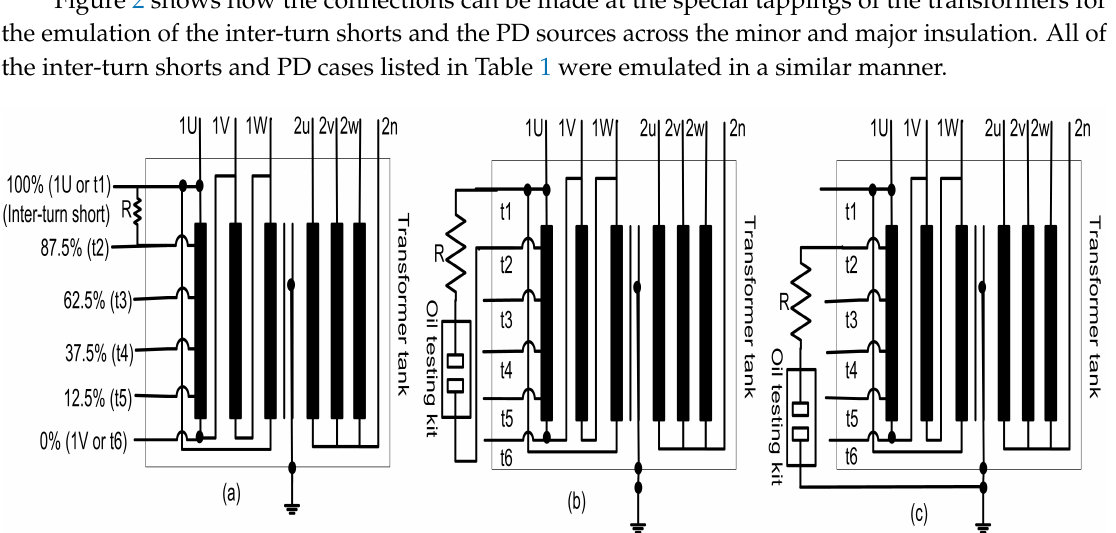
Figure 2. Circuit connections for emulation of faults: ( a ) Inter-turn short (Sh-1). ( b ) PD source across minor insulation (PD-1-minor) ( c ) PD source across major insulation